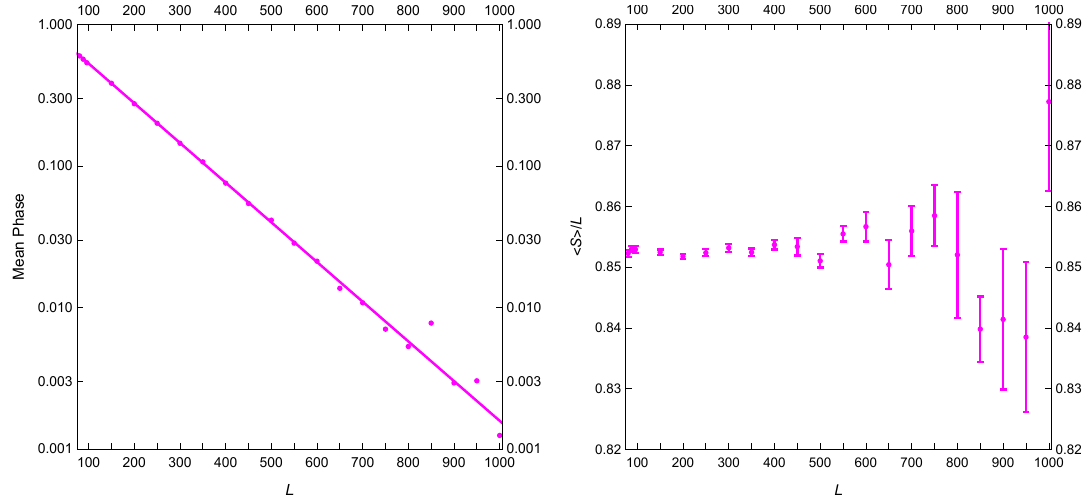
Figure 6 . The onset of the sign problem for contour 4. Left: the mean phase as a function of lattice size on a logarithmic scale together with the previously obtained linear (cid:12)t. Right: the action density as a function of lattice size.